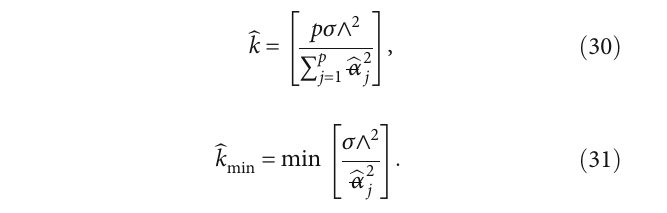
Table 9: The regression output.